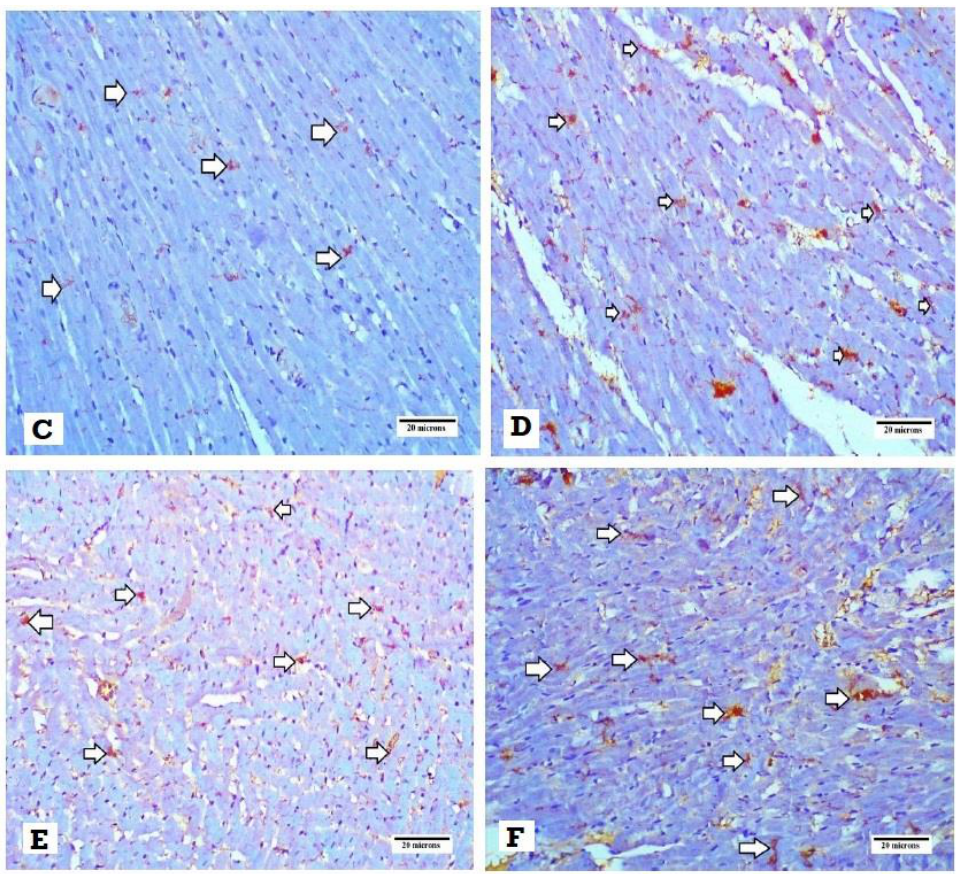
Figure 5. Effects of SGLTi and GLP1 on the myocardial norepinephrine content and density of sympathetic nerve fibers by tyrosine hydroxylase (TH). ( A ) The concentration of myocardial NE in different groups, ( B ) the density of sympathetic nerve fibers by TH immunostaining in different groups, ( C ) heart specimen from the control group showing evenly distributed TH-positive nerve fibers in the ventricular myocardium (arrows) (400×), ( D ) heart specimen from the DM group showing marked increase in immunopositivity for TH-positive fibers (arrows) (400×), ( E ) heart specimen from the DM +GLP1 group showing moderate increase in immunopositivity for TH-positive fibers (arrows) (400×), and ( F ) heart specimen from the DM +SGLT2i group showing minimal increase in TH-positive fibers (arrows) (400×). * Significant vs control group, # significant vs DM group, and $ significant vs DM+ SGLT2i group.